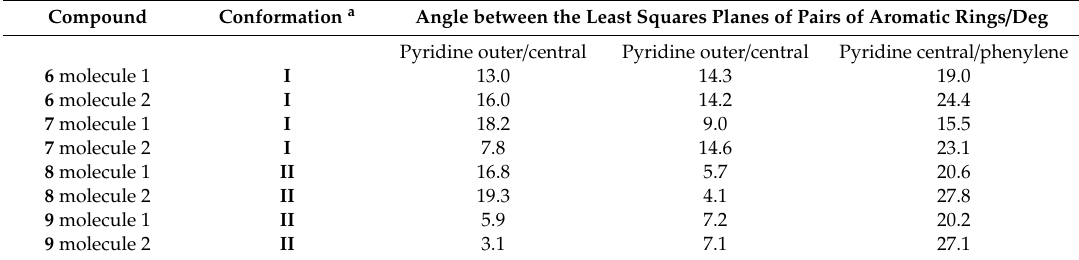
Table 3. Selected structural parameters in compounds 6 – 9 ; there are two crystallographic independent molecules of each compound.